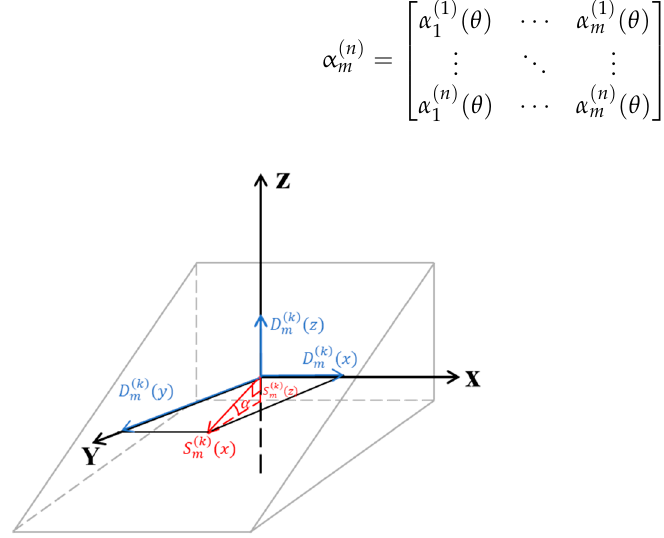
Figure 8. Schematic map illustrating the displacement vector angle (DVA). In Newton’s second law, (cid:1832)(cid:1318) = (cid:1865)(cid:1853)(cid:1318) = (cid:1865)(∆(cid:1874)(cid:1318) (cid:1872)⁄ ) , ∆(cid:1874)(cid:1318) represents the difference in the displacement rates between two adjacent time series. This implies that the directions of (cid:1832)(cid:1318) and ∆(cid:1874)(cid:1318) are the same, which means that the change direction of (cid:1832)(cid:1318) is followed by the change direction of ∆(cid:1874)(cid:1318) . Therefore, the stability state of the landslide can be predicted by analyzing the dynamic change direction of the displacement vector before and after the two periods. As shown in Figure 9, (cid:2009) (cid:2869) and (cid:2009) (cid:2870) represent the DVAs in the two consecutive periods. When the velocity gradually increases, as shown in Figure 9a, when ∆(cid:2009) (cid:3408) 0 and ∆(cid:1874)(cid:1318) (cid:3408) 0 , the lower soil is compressed by the upper soil due to sliding force (cid:1832)(cid:1318) , and the DVA changes from small to large. The slope is subjected to tensile stress. As shown in Figure 9b, when ∆(cid:2009) = 0 and ∆(cid:1874)(cid:1318) (cid:3408) 0 , the DVA is relatively stable; the slope slides overall; and the landslide is in the constant deformation stage. As shown in Figure 9c, when ∆(cid:2009) (cid:3407) 0 and ∆(cid:1874)(cid:1318) (cid:3408) 0 , the DVA changes from large to small. The slope is subjected to squeezing and shearing in the stress state due to sliding force (cid:1832)(cid:1318) . When the sliding surface is in a plastic state, the surface DVA of the slope is mutated. This mutation inevitably causes the DVA to increase or decrease. The DVA abruptly decreases in the extruded shear outlet region and abruptly increases in the tensioning and loosening zones. Thus, the changes in the DVA reflect the changes in the force direction and displacement of the slope body. Figure 9. The relationship between DVA and sliding force (cid:1832)(cid:1318) . ( a ) ∆(cid:2009) (cid:3408) 0 and ∆(cid:1874)(cid:1318) (cid:3408) 0 ; ( b ) ∆(cid:2009) = 0 and ∆(cid:1874)(cid:1318) (cid:3408) 0 ; ( c ) ∆(cid:2009) (cid:3407) 0 and ∆(cid:1874)(cid:1318) (cid:3408) 0 . 4. Simulation Results The simulation results show that the bond strength among soil particles in the initial equilibrium state was gradually reduced by different reduction factors until the strength reduction stopped at 20,000 steps. After moving along the slope, these particles accumulated in the river channel at the toe of the slope. The river was incised by sliding particles, and barrier lakes were formed. 4.1. Kinetic Features of the Jinpingzi Landslide